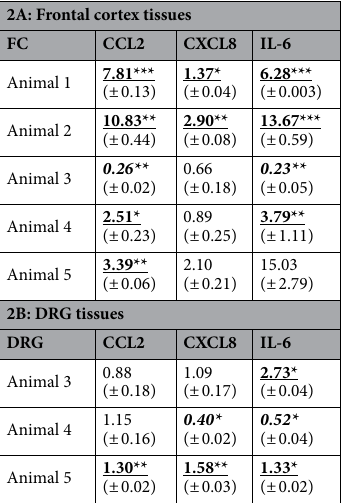
Table 2. Fold change in cytokine levels induced by non-viable B. burgdorferi over live bacteria induced levels. Fold change was calculated as levels induced by non-viable B. burgdorferi divided by those induced by live bacteria. Values were calculated from levels in Figs. 1 and 2. Numbers greater than 1 indicate higher levels induced by non-viable bacteria, while those less than one indicates higher levels induced by live bacteria. Values that are bold and underlined indicate statistically significant increase in non-viable Borrelia induced levels, while those in bold and italics indicates statistically significant lower levels, compared to those induced by live bacteria. Other values indicate no statistically significant difference. Standard deviation is shown with in brackets. FC frontal cortex, DRG Dorsal root ganglion. *p < 0.05, **p < 0.01, ***p <